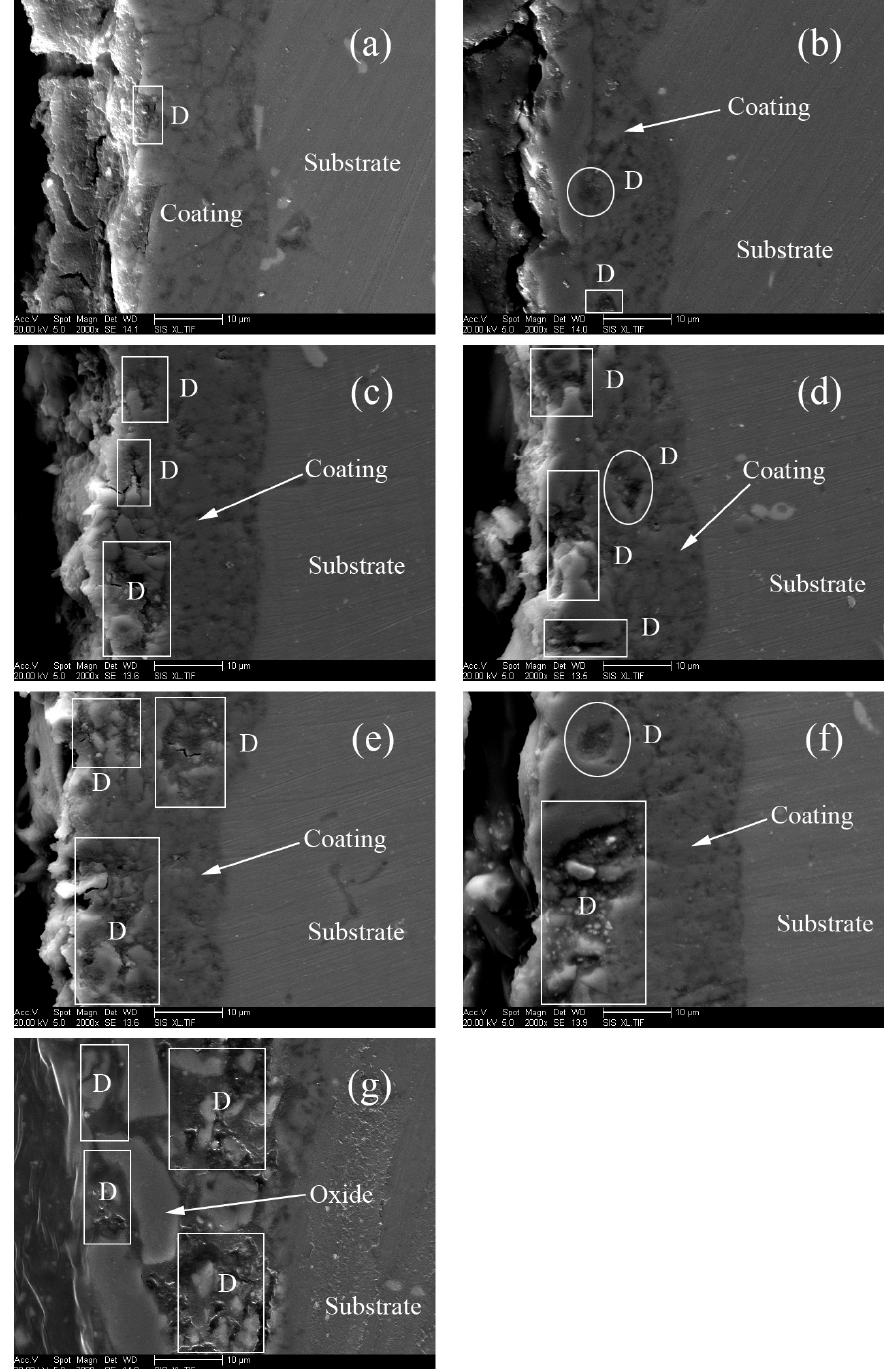
Figure 5. The cross-section morphologies of microarc oxidation coatings formed on aluminum alloys at different anode pulse-widths. ( a ) 1000 μ s; ( b ) 1500 μ s; ( c ) 2000 μ s; ( d ) 2500 μ s; ( e ) 3000 μ s; ( f ) 3500 μ s; ( g ) 4000 μ s.